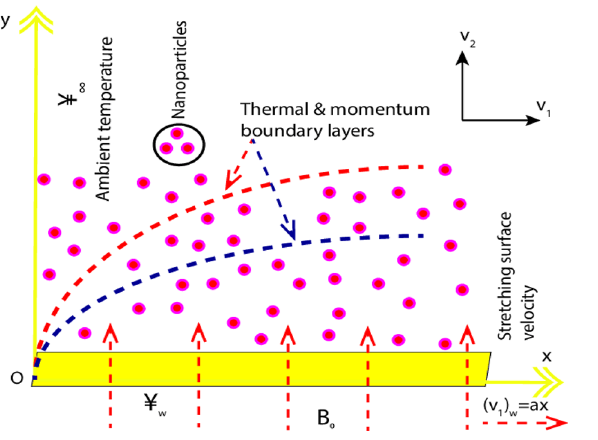
Figure 1. Physical flow